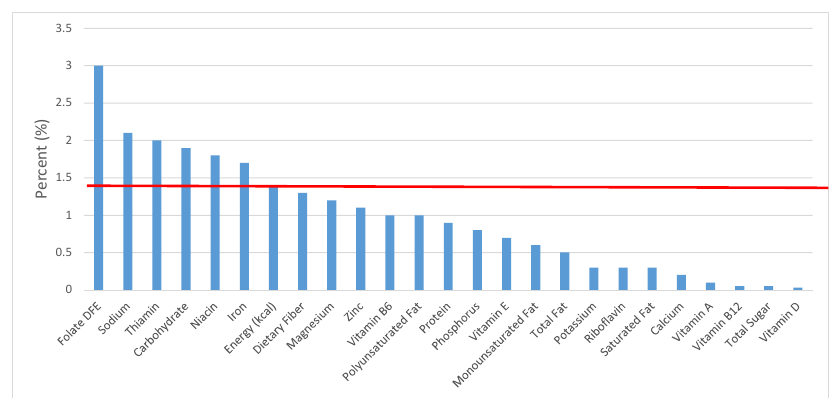
Figure 17. Cooked grains as sources of energy and nutrients for children 1–3 years old ( N = 1423, daily intake data): DFE = Dietary Folate Equivalents; solid red line represents percentage of energy (kcal) provided in the diet relative to nutrients—nutrients above the red line show the grain food’s contribution to nutrient density.